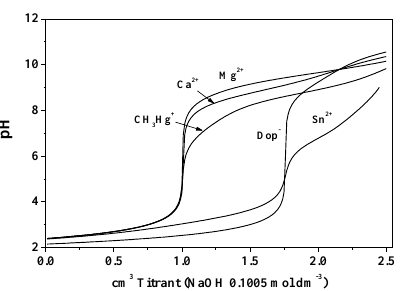
Figure 1. Titration curves of dopamine and of the different metal/Dop − systems at T = 298.15 K and I = 0.15 mol dm −3 . (Experimental conditions: c Dop- = 3 mmol dm −3 ; c Mn+ = 1.5 mol dm −3 ).